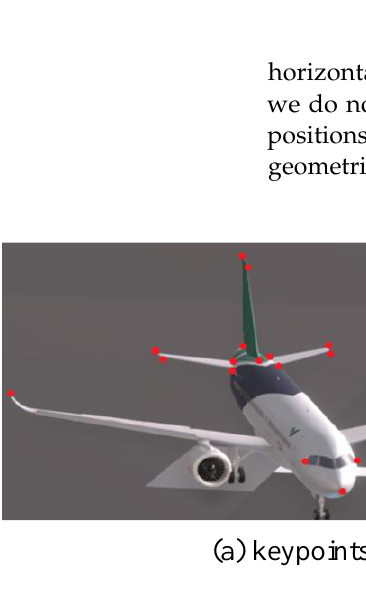
Figure 6. Keypoints and structures definition. As shown in ( a ), 17 points on the aircraft surface are defined as keypoints. In ( b ), six segments which characterize the geometric relationship between different parts of the aircraft are defined as structures.